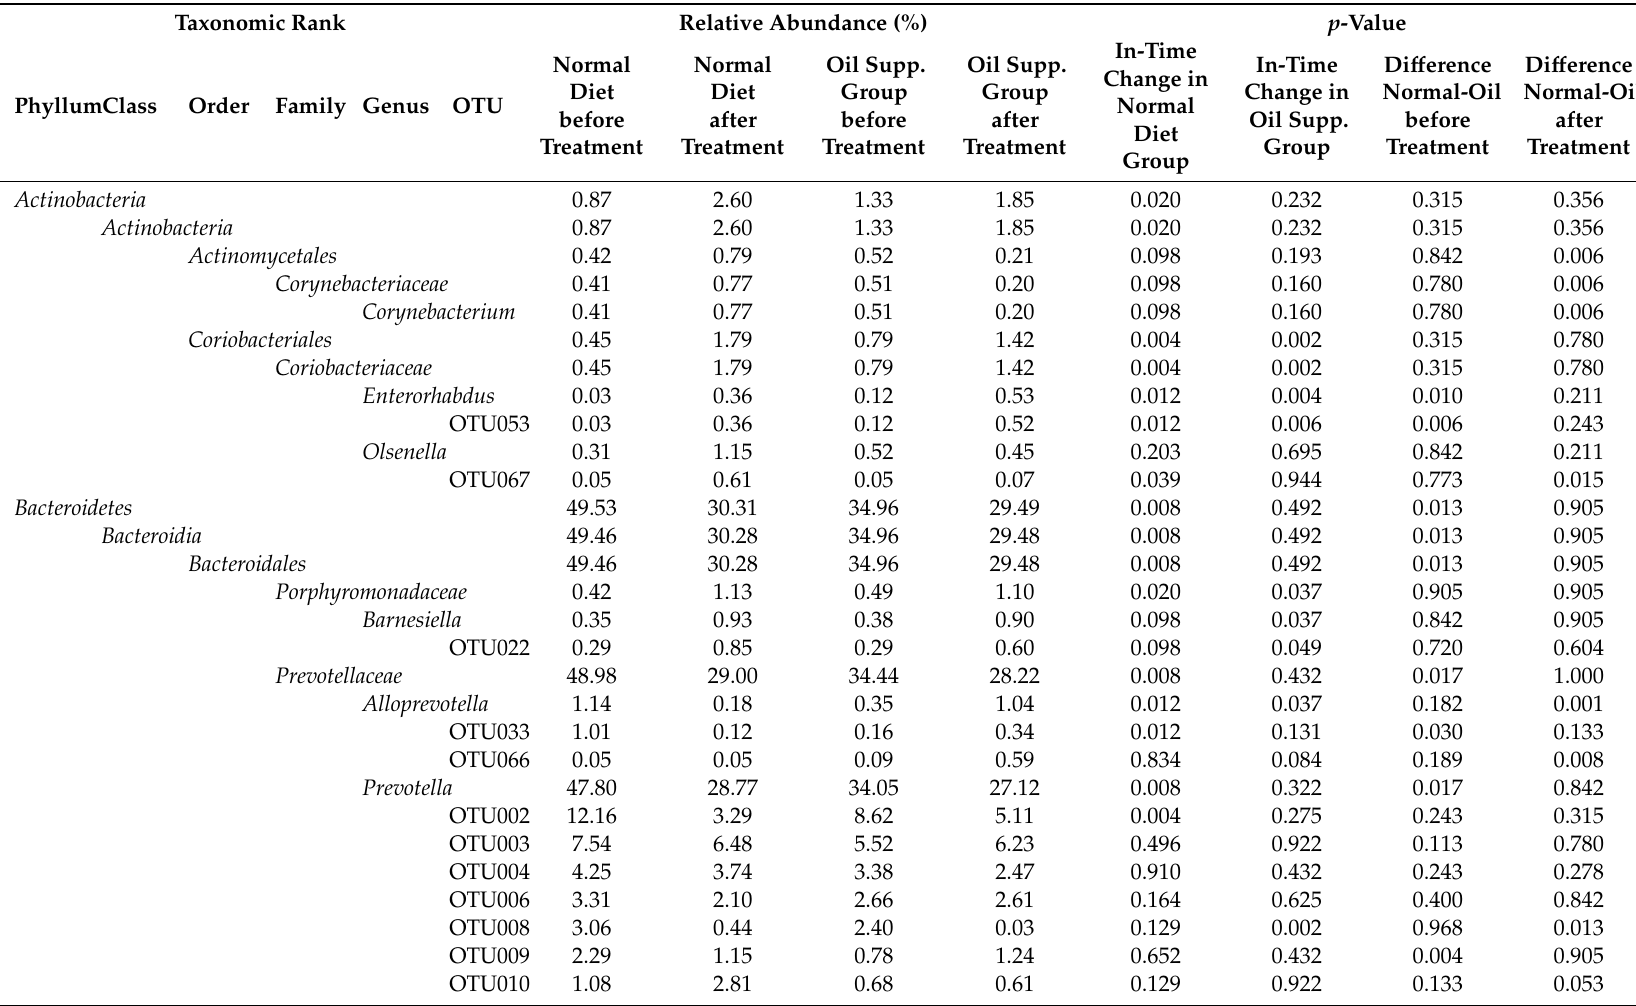
Table 2. Microbial community members with occurrences of at least 0.5% in rectal swabs of pigs fed a normal diet and a diet supplemented with coconut oil and the significance of changes between groups during